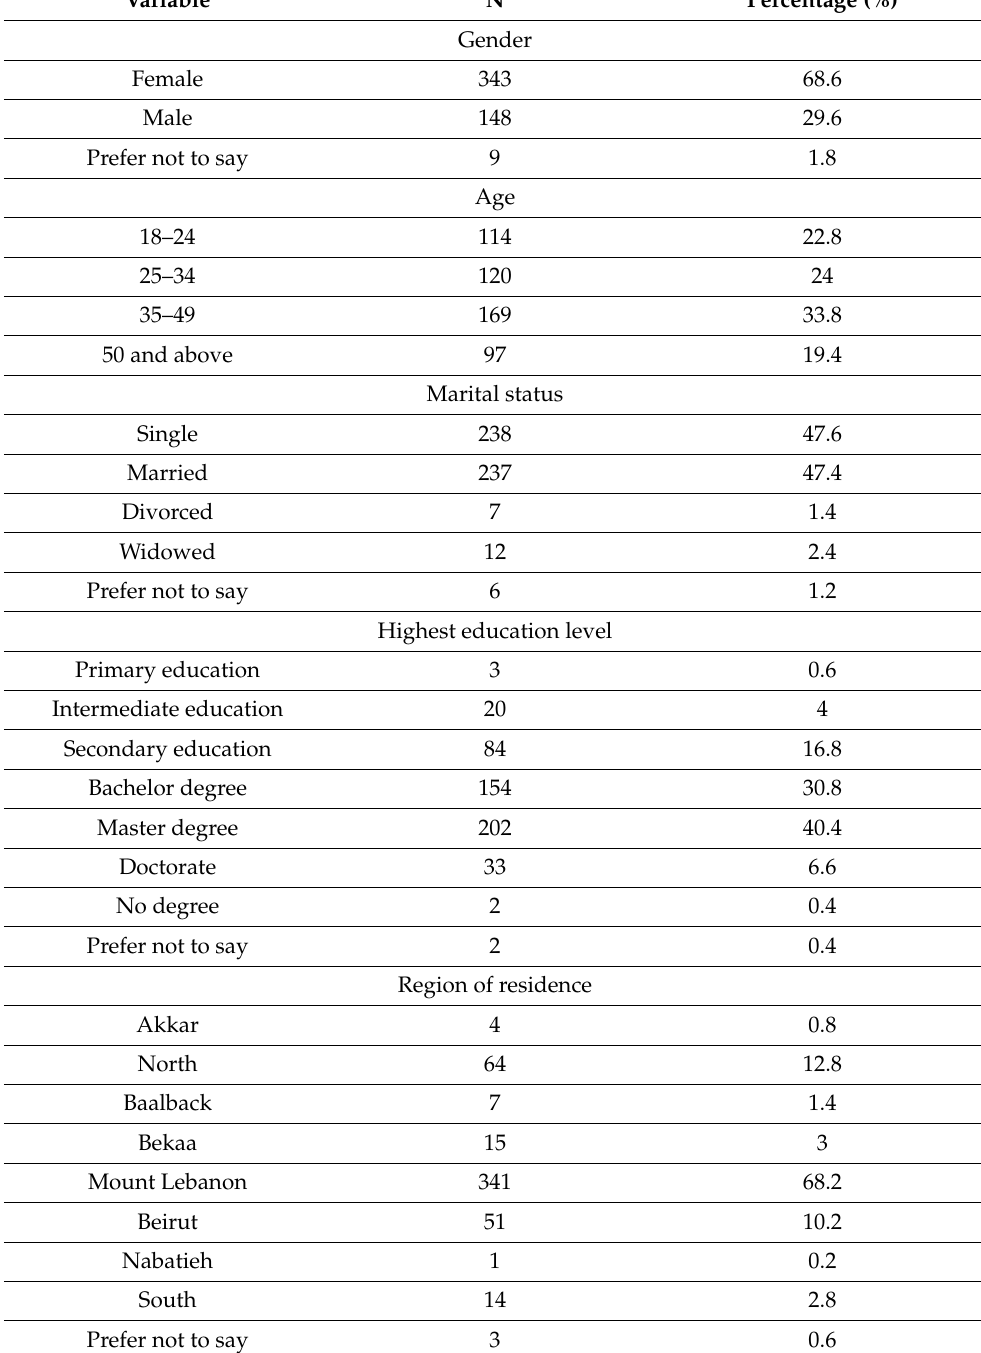
Table 2. Participants’ demographic